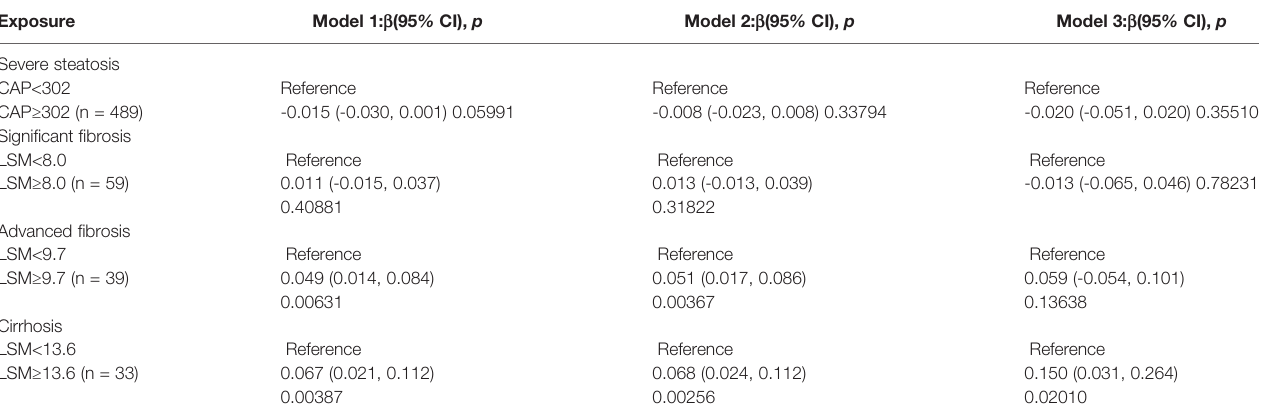
TABLE 6 | Association between degree of hepatic steatosis and lumbar bone mineral density (g/cm2). Exposure